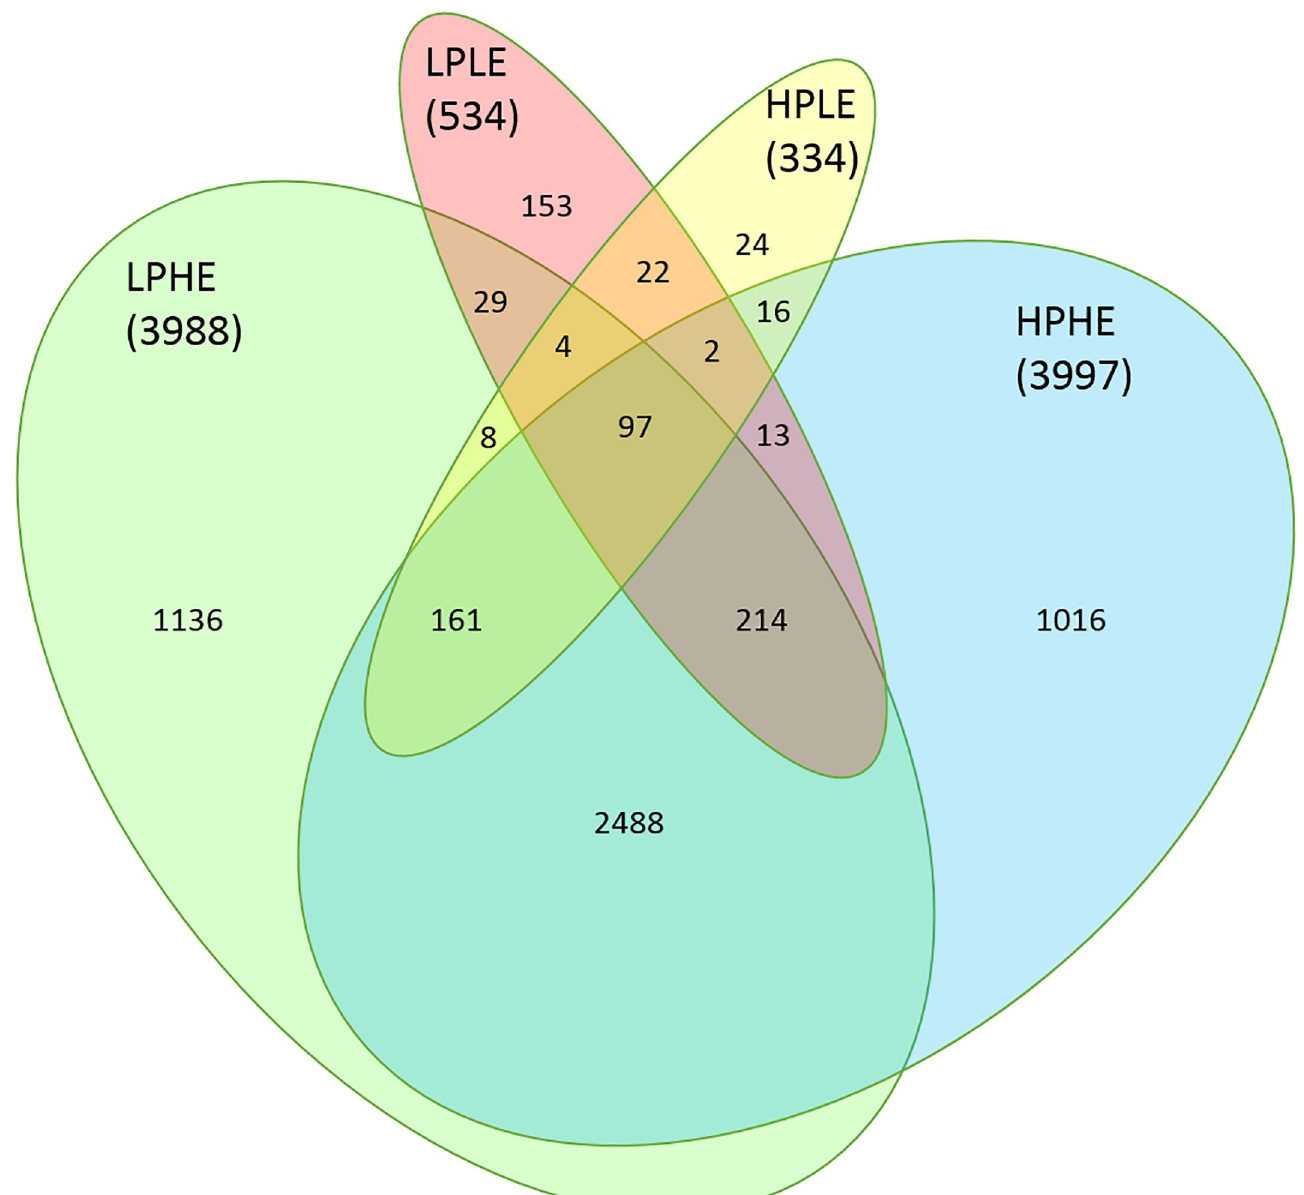
Fig 3. Unique and shared differentially expressed genes (DEG) from the experimental feeding period (12MO) to pregnancy (PREG). The diagram shows the number of differentially expressed genes unique to or shared between experimental treatment groups from experimental feeding at 12 months of age, to month 7 of gestation (at which point all heifers had received the same diet for 6 months). LPHE = Low-protein, High-energy; HPHE = High-protein, High-energy; LPLE = Low-protein, Low-energy and HPLE = High-protein, Low-energy (HPLE). Numbers in parentheses are the total number of differentially expressed genes found for each treatment. (Venn diagram modified from VennDiagram and Venneuler R packages).